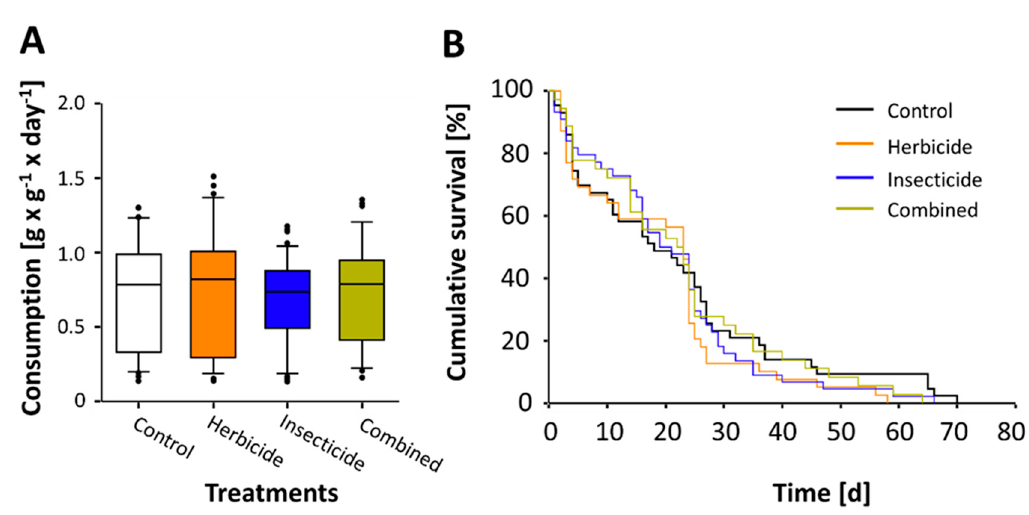
Figure 1. Consumption and cumulative survival of female adult solitary bees ( Osmia bicornis ). ( A ) Relative daily consumption measured during the 10-day exposure period revealed no significant differences among treatment groups ( meglm , p > 0.73). The boxplots show the inter-quartile range (box), the median (black-line within the box), data range (horizontal black lines from the box), and outliers (black dots). ( B ) Likewise, cumulative survival analyses until all bees had died revealed no significant differences among treatment groups ( mestreg , p > 0.85).